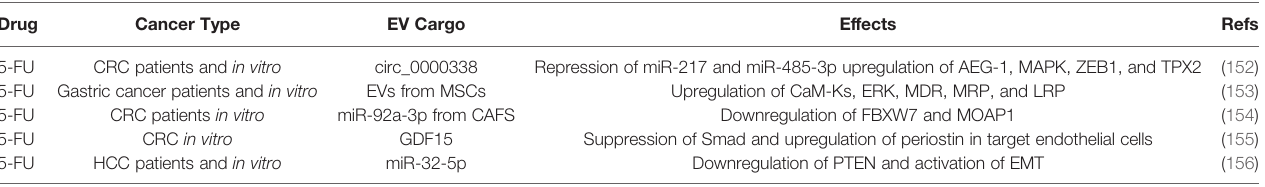
TABLE 2 | Resistance to antimetabolites mediated by